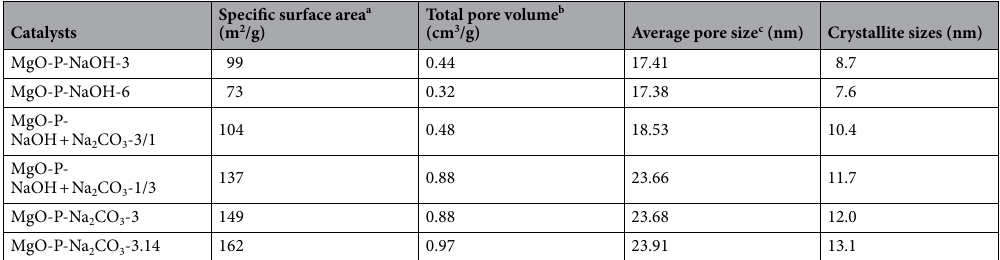
Table 2. The characterization of various MgO catalysts. a Calculated by Brunauer–Emmett–Teller (BET) method; b Volume adsorbed at P/P 0 = 0.99; c Calculated based on BJH method.